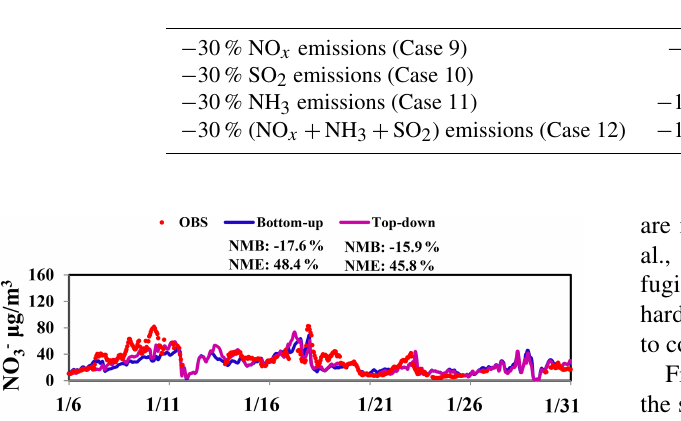
mented. In actual fact, controlling VOCs is more difficult than NO x . Compared to NO x that come mainly from